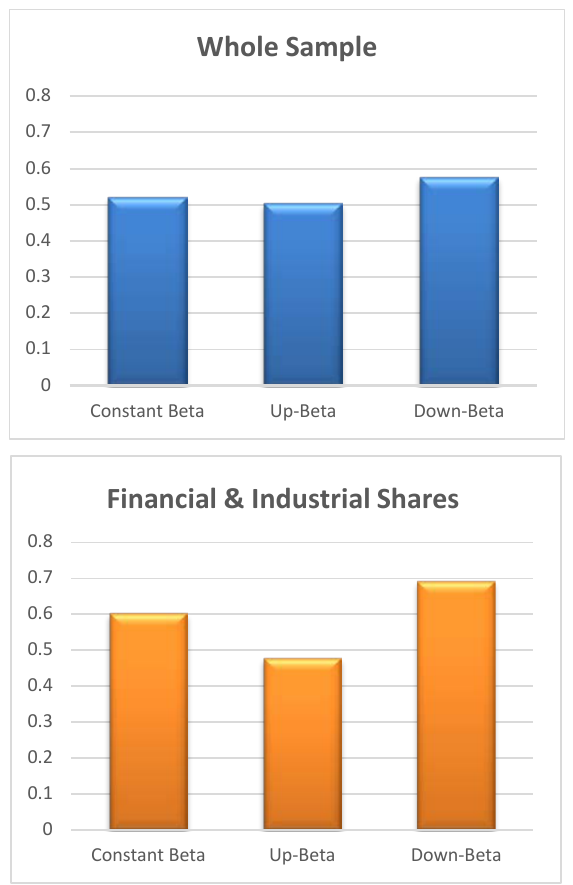
FIGURE 3: Beta Comparisons Source: own